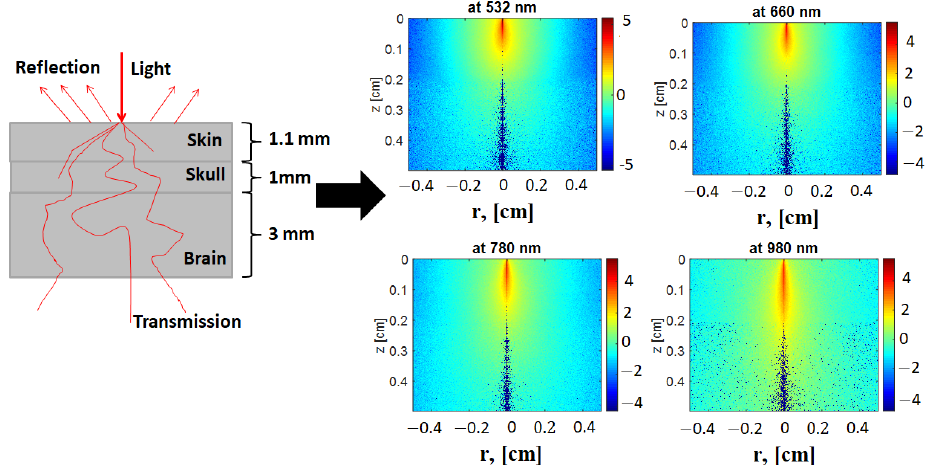
Figure 14. The distribution of the optical fluence rate (logarithm of the fluence values) in the model containing the three layers (skin, skull, and brain).